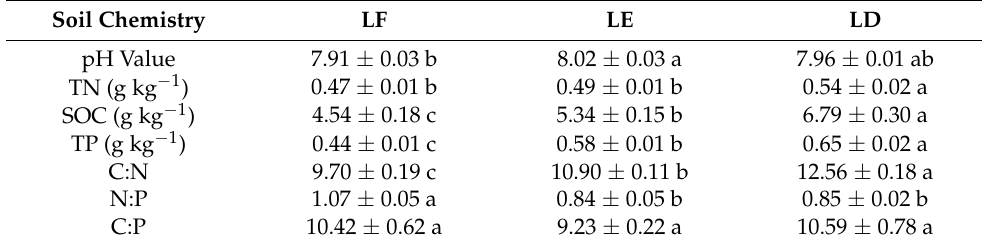
Table 1. Rhizosphere soil physicochemical properties and soil stoichiometry under different treatments.